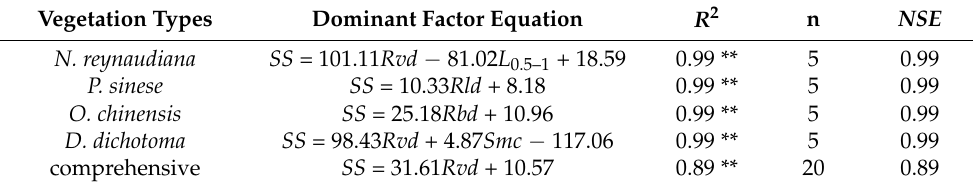
Table 10. The dominant factor equation of soil shear strength of different root–soil complexes ( SS ).